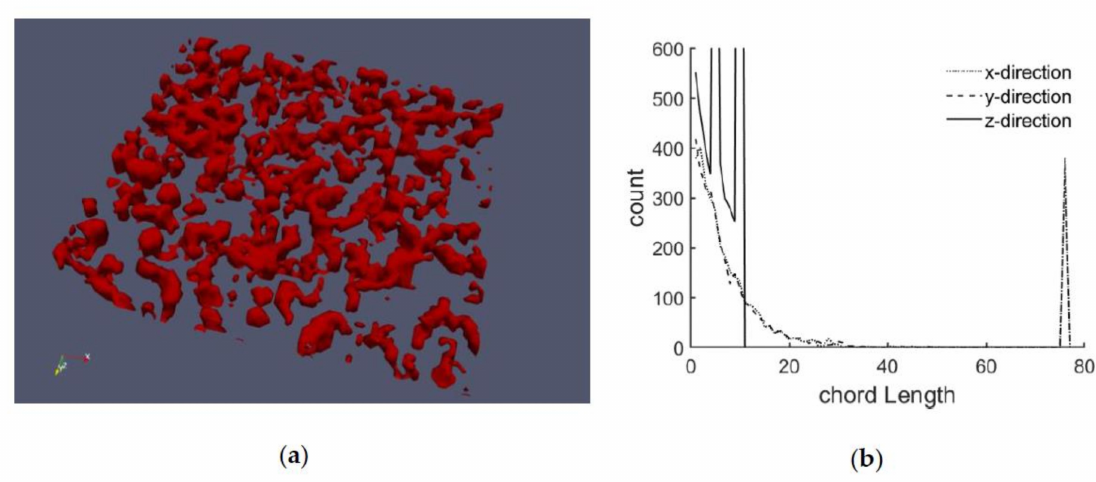
Figure 3. Measured actin network of a beta cell: ( a ) images of 10 layers processed to a 3D network, ( b ) chord length distributions of the network illustrated in ( a ).